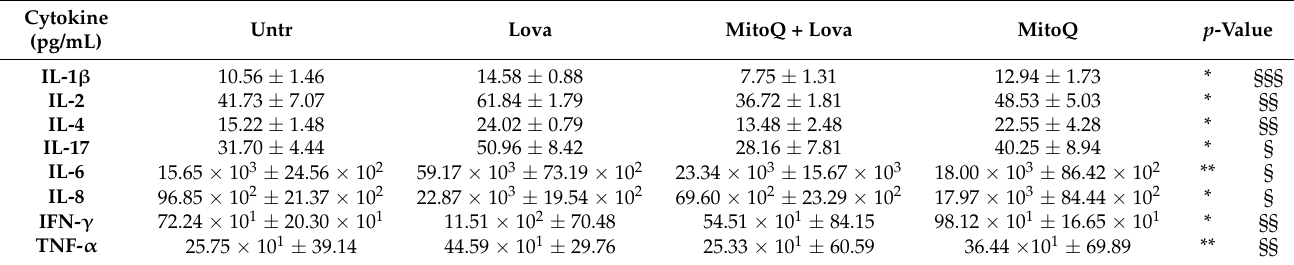
Table 1. Cytokine’s quantification at 12 h is expressed in pg/mL. Statistically significant p -values are shown (Lova vs. Untreated: * p < 0.05; ** p < 0.01; MitoQ + Lova vs. Lova: § p < 0.05; §§ p < 0.01; §§§ p < 0.001 based on one-way ANOVA, post-test Bonferroni).